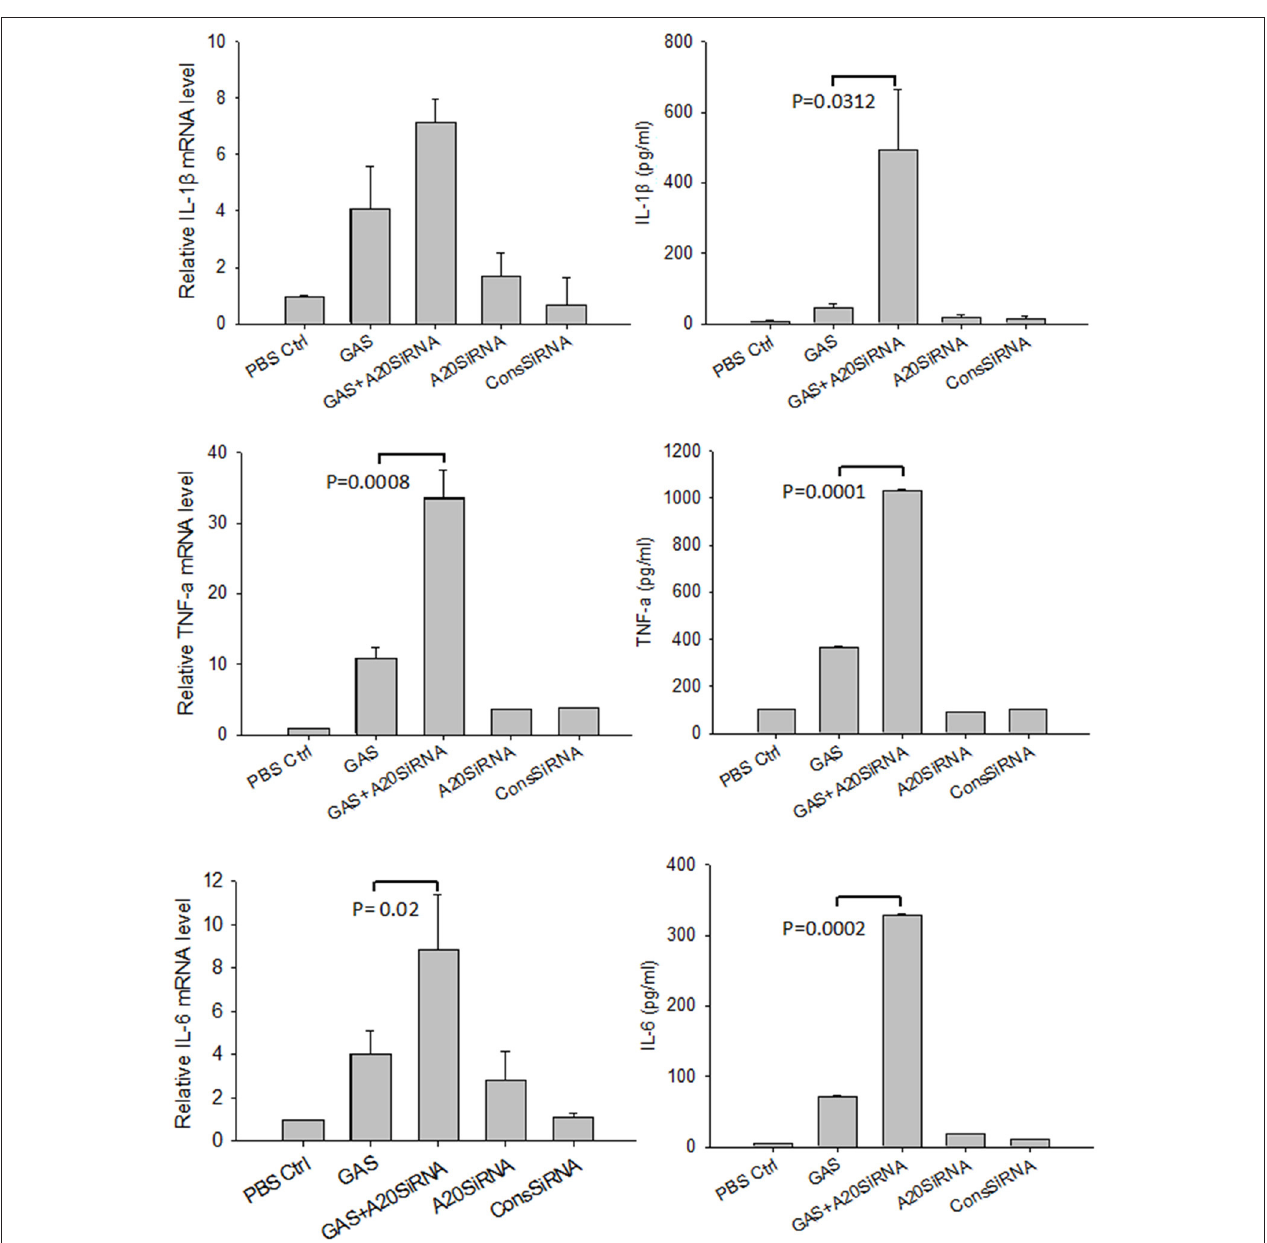
FIGURE 5 | Expression of proinflammatory cytokines in RAW 264.7 macrophages with and without A20 SiRNA following GAS infection. RAW 264.7 cells were incubated with A20 SiRNA for 30min, and then infected with GAS at an MOI of 10. And 6h post-infection, ELISA and RT-PCR were performed to analyze the expression of proinflammatory cytokines. Each experiment was repeated three times, and similar results were obtained on each occasion. Results are presented as mean ± SD.